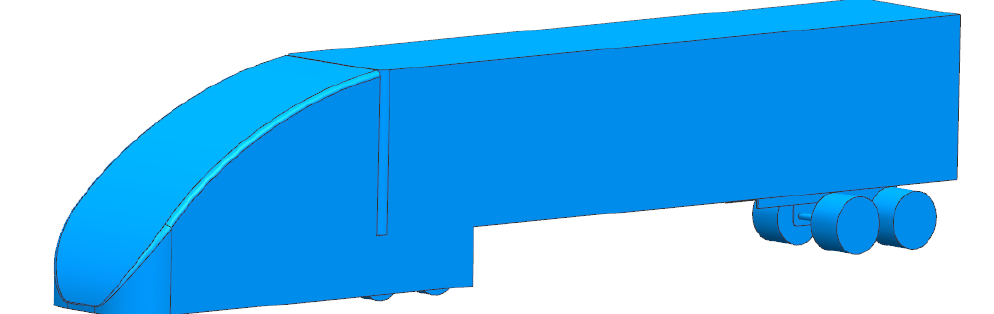
Fig. 6. Autonomous BET Concept